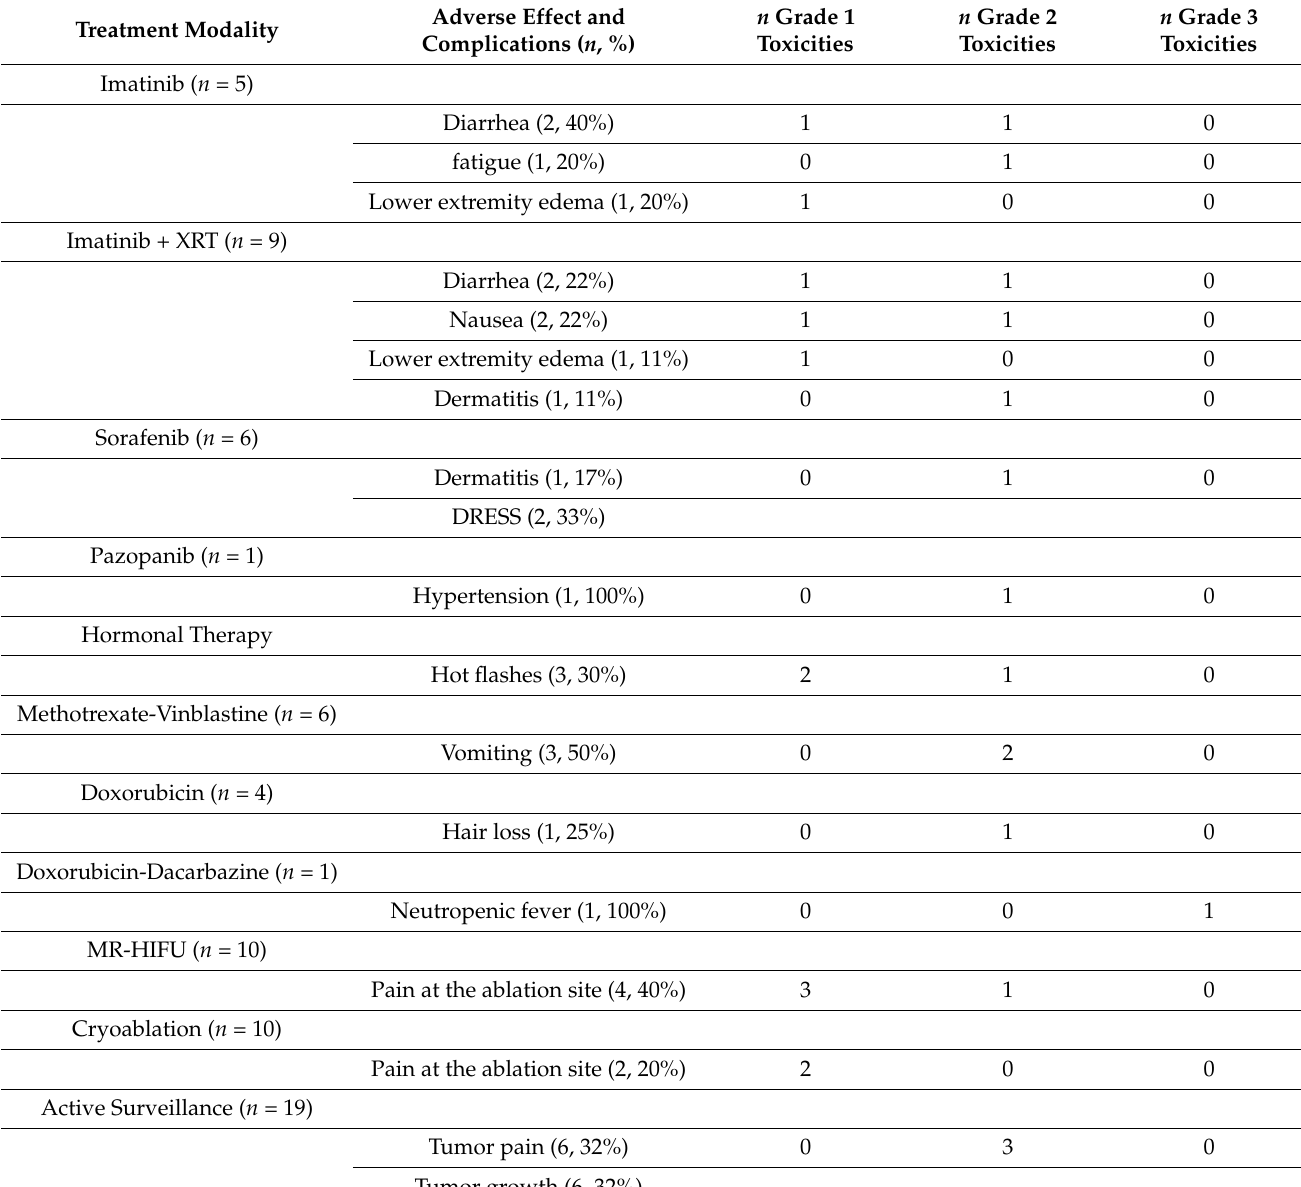
Table 4. Adverse effects and complications after first-line therapy in desmoid